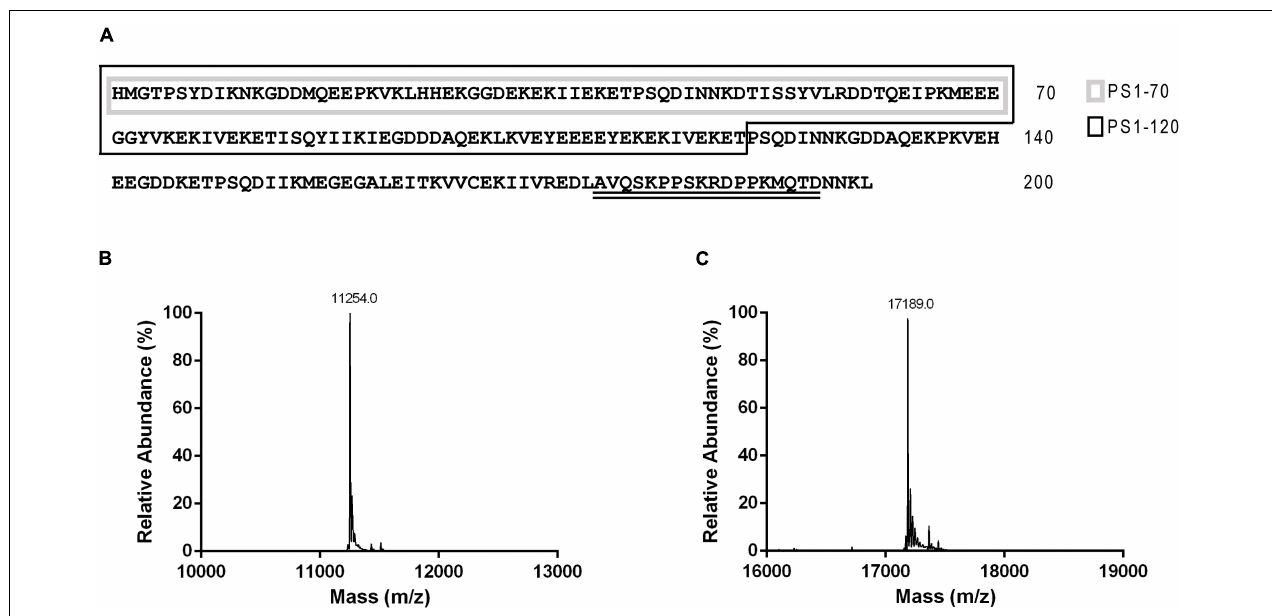
FIGURE 1 | Primary sequences of ProSys and its fragments PS1-70 and PS1-120 and LC-ESI-MS analysis of the two fragments. (A) ProSys primary sequence: PS1-70 and PS1-120 sequences are indicated by a gray and a black box, respectively; Systemin sequence is double underlined. Deconvoluted mass spectrum of purified (B) PS1-70 and (C)